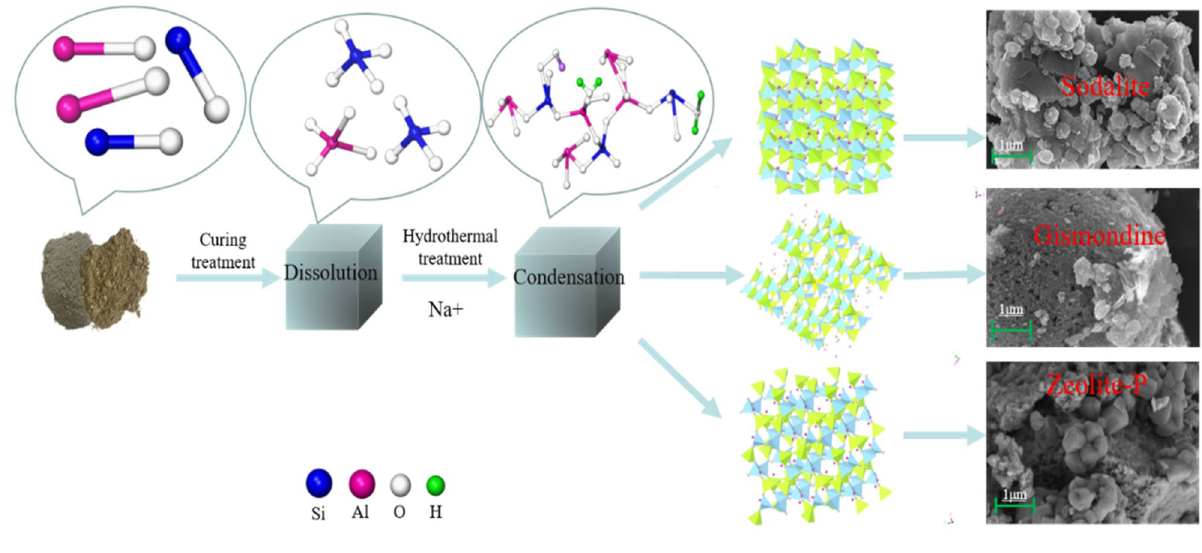
Figure 12. The Mechanism formation of